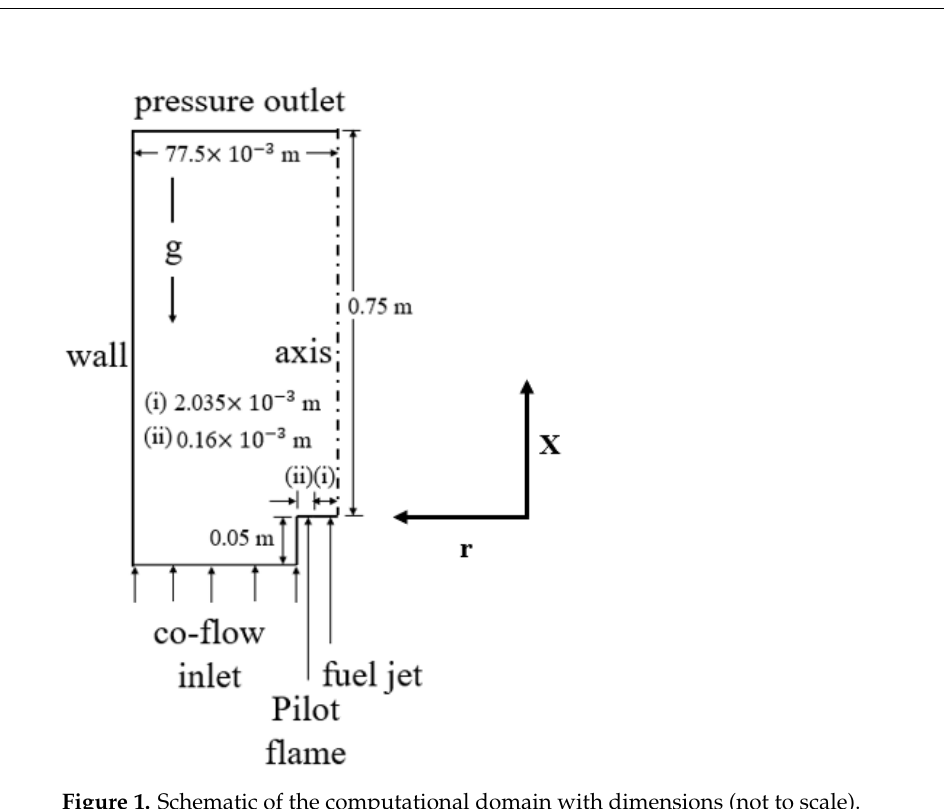
Figure 1. Schematic of the computational domain with dimensions (not to scale).